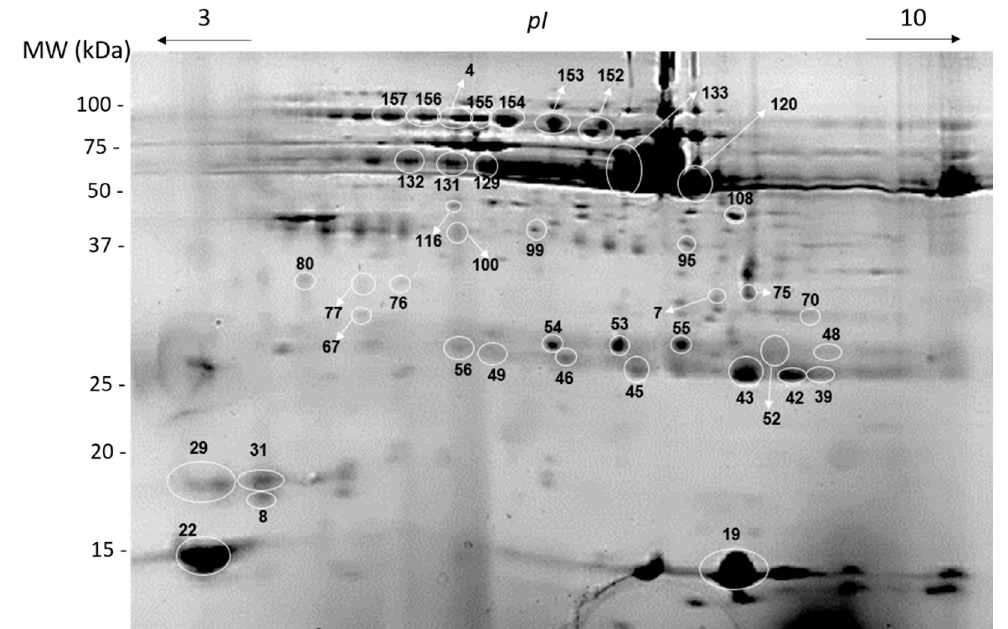
Figure 3. Representative 2 ‐ DE saliva protein profiles. Numbered spots are the ones differently expressed between stimuli and/or periods.